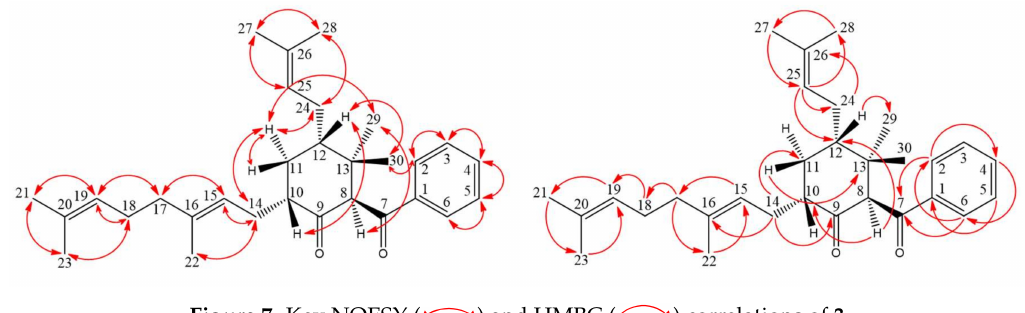
Figure 7. Key NOESY ( ) and HMBC ( ) correlations of 3